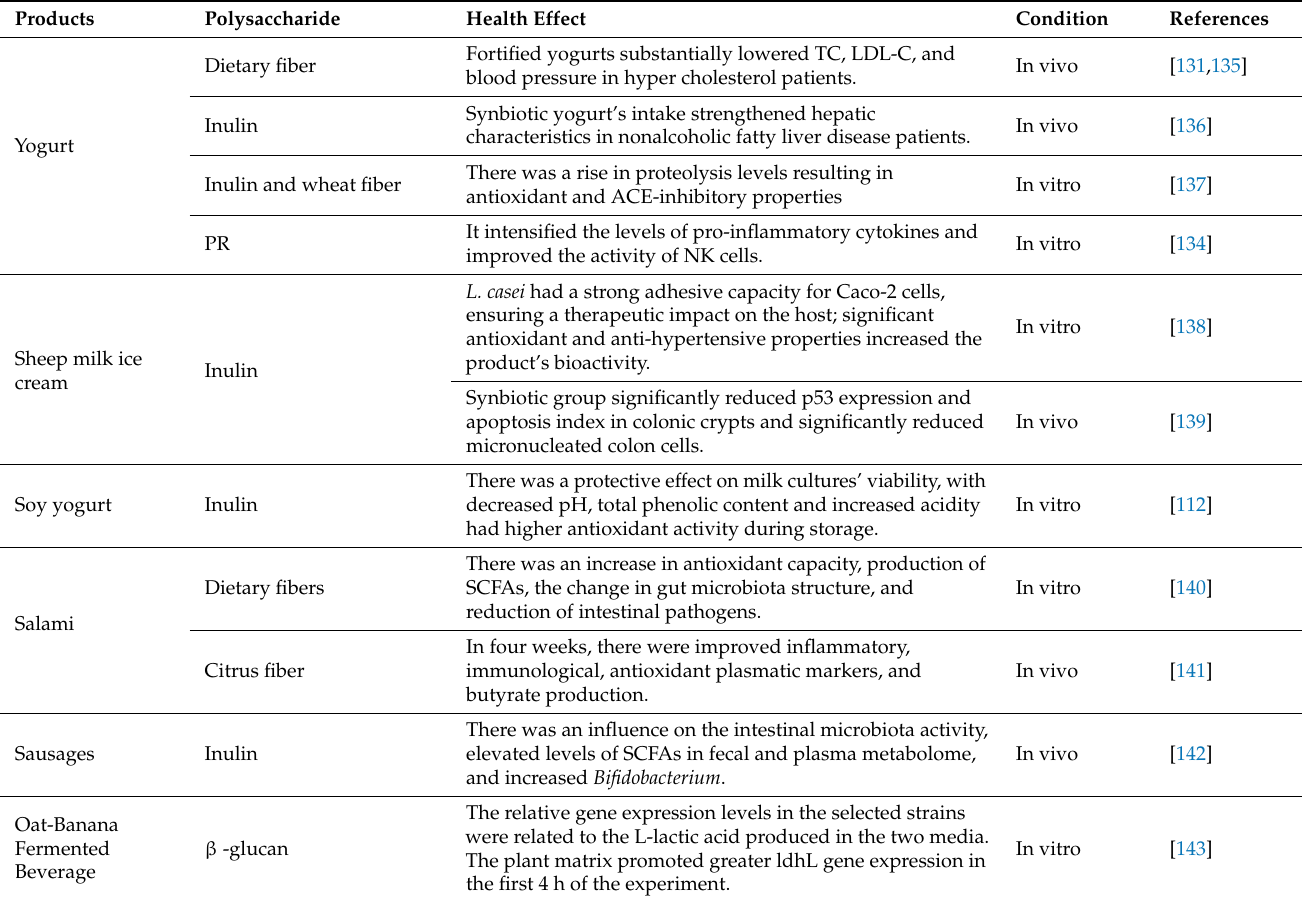
Table 3. Health benefits of the intake of fermented foods with plant